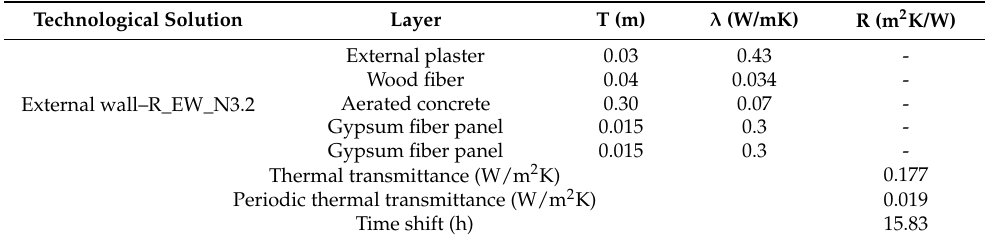
Table A26. Possible redevelopment measure for external wall characterized by the half value of the thermal transmittance of the reference building with ETICS as external finishing (R_EW_N3.2).